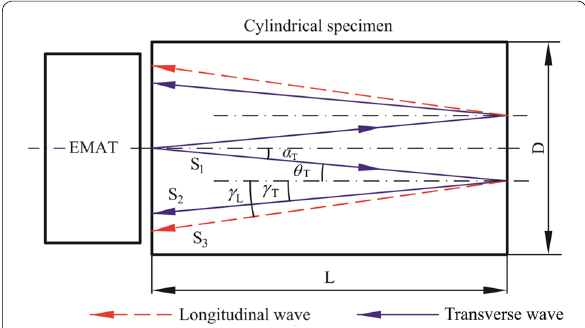
Figure 12 Ray paths of a mode-converted ultrasound of a cylindrical specimen